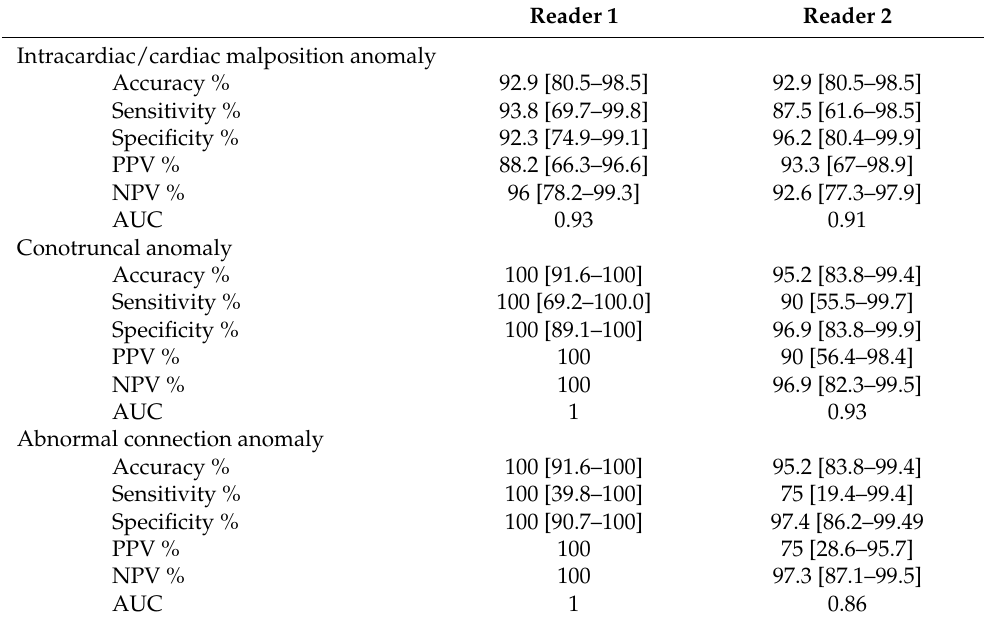
Table 6. Diagnostic validity of the low-dose prospective ECG-triggering cardiac CT in diagnosing complex